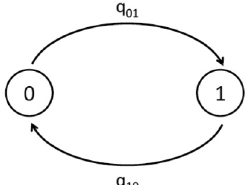
Figure 6. Transition diagram for one force